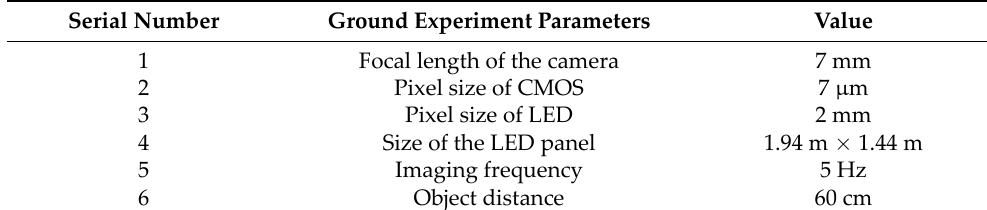
Table 4. Ground experiment parameters.